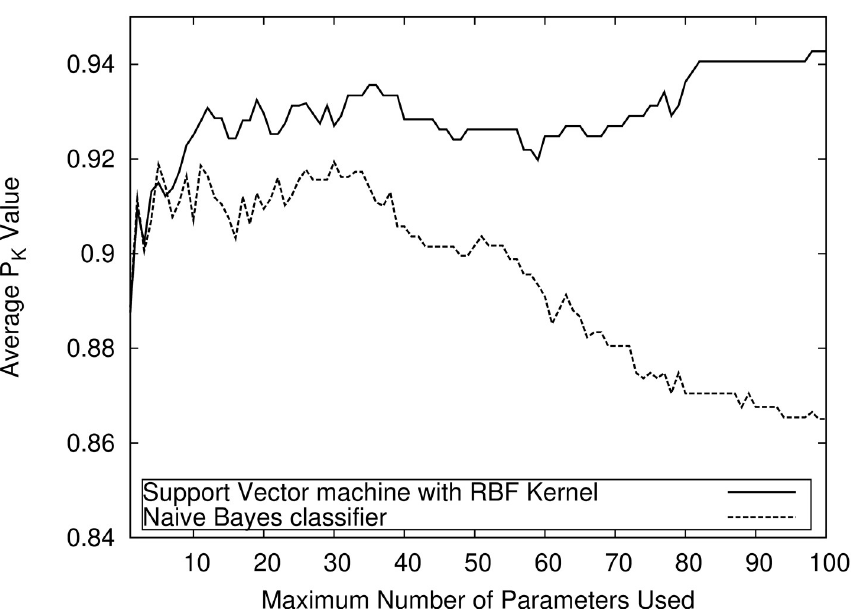
Fig 2. High-dimensionality performance. Performance comparison on large parameter sets between a SVM and a Naive-Bayes Classifier. The SVM is able to tolerate high-dimensional data input, while the performance of the Naive- Bayes-Classifier is decreasing.